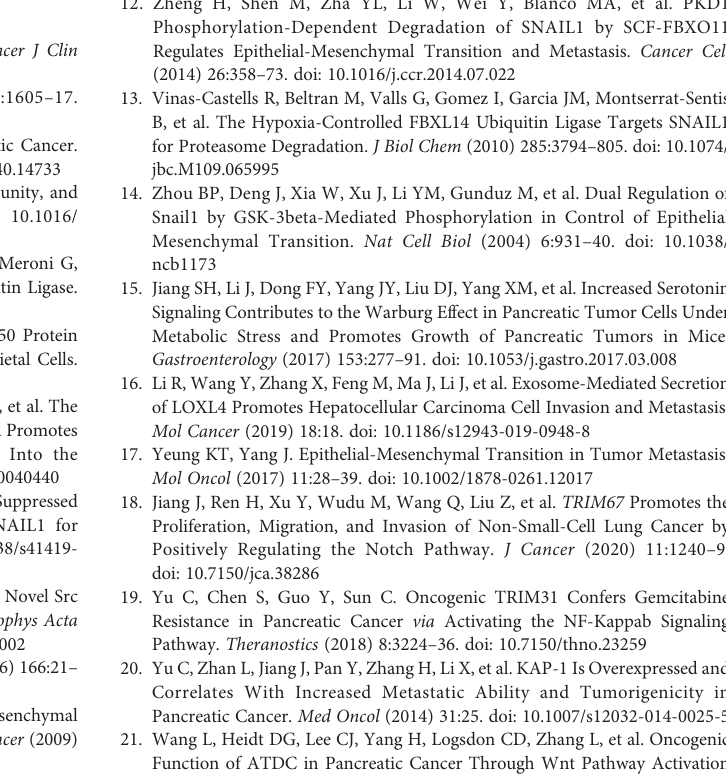
Supplementary Figure 1 | Univariate analysis showing the association between TRIM50 expression and pancreatic cancer survival. Supplementary Figure 2 | Rescue of TRIM50 recovers its antioncogenic roles in pancreatic cancer. (A) Western blotting analysis of TRIM50 and mutated TRIM50 (mTRIM50) proteins was performed with extracts from PANC-1 and SW1990 cells transfected with control siRNA or siTRIM50-1 and either mTRIM50-expressing plasmid or empty vector. (B – D) Rescue of TRIM50 recovered the inhibiting effects of TRIM50 on cell proliferation (B) , cell invasion (C) , and the expression of EMT markers (D) . Scale bar: 50 m m. ** P < 0.01 and *** P < 0.001. Supplementary Figure 3 | The expression of EMT-related transcription factors followed by TRIM50 overexpression or depletion. (A, B) The effect of TRIM50 overexpression (A) or depletion (B) on the expression of EMT-related transcription factors at mRNA level. (C, D) The effect of TRIM50 overexpression (C) or depletion (D) onthe expressionofEMT-related transcriptionfactorsatproteinlevel.* P <0.05; ns, no signi fi